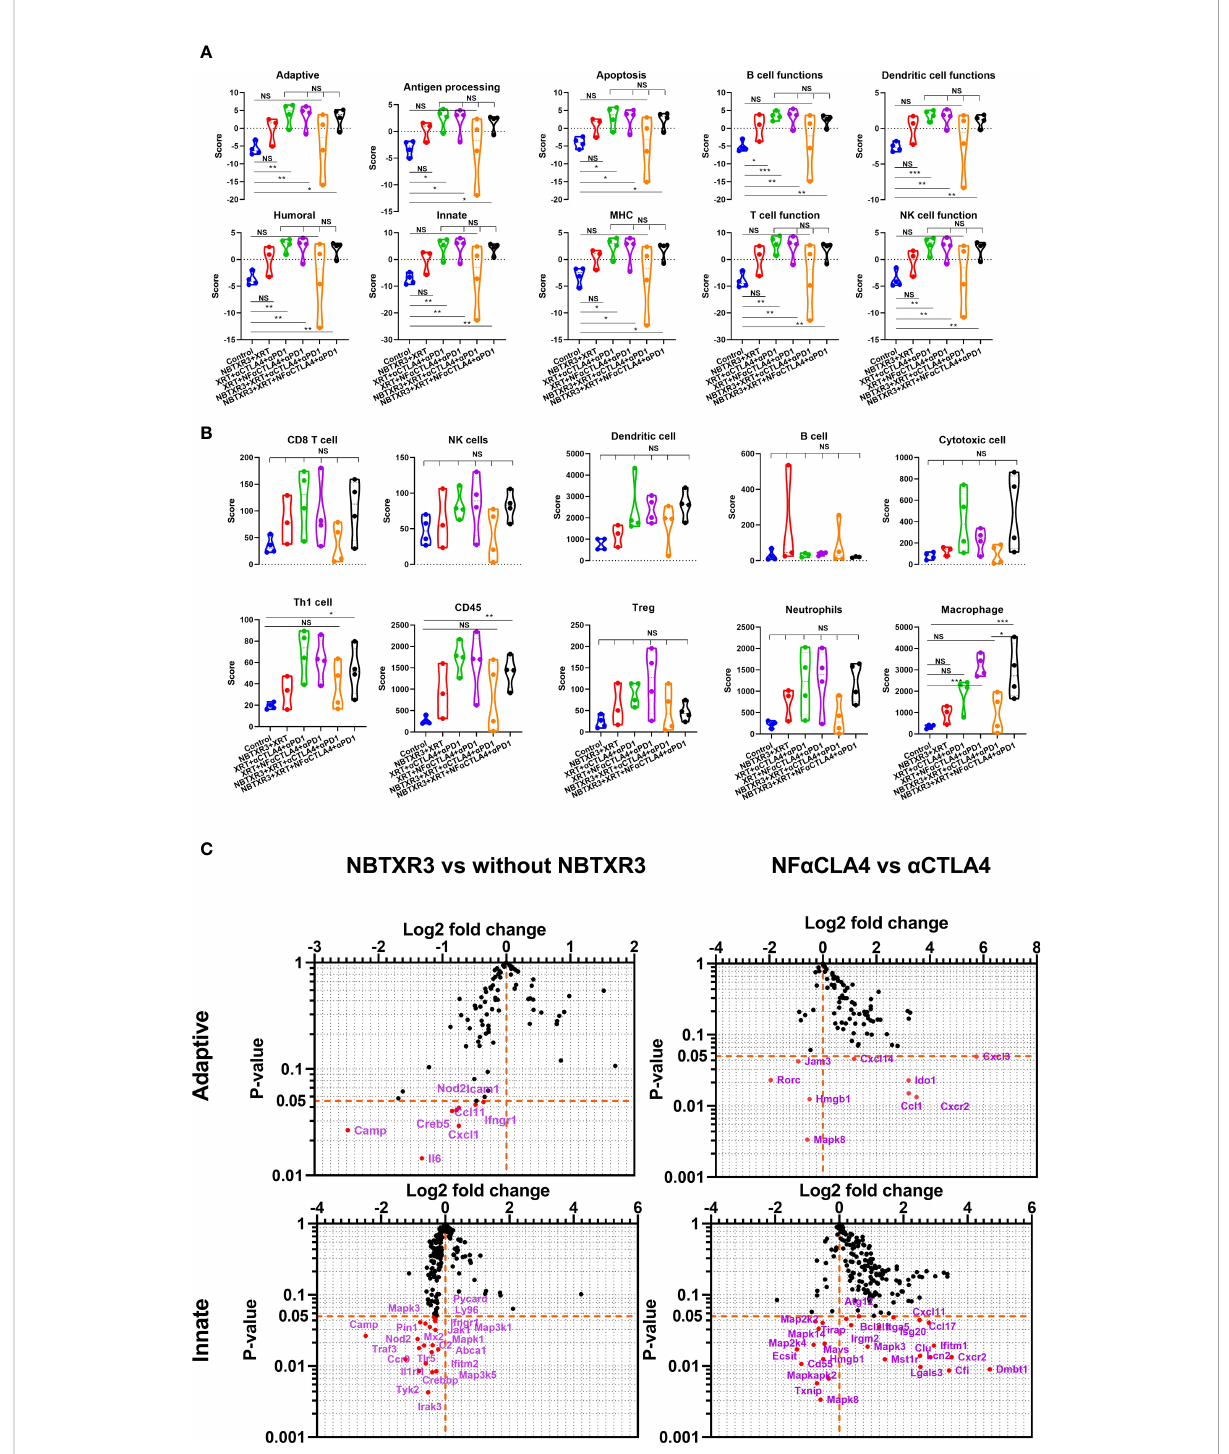
FIGURE 3 NBTXR3, combined with NF- a CTLA4, modulates immune-related gene expression to improve the primary tumor ’ s antitumor immune response. (A) Activities of immune pathways in the primary tumors. (B) The score of immune cell abundance in the primary tumor. (C) Changes in gene expression in adaptive and innate immune pathways. Mice bearing 344SQR tumors were treated with various immunoradiotherapies as indicated in Figure 1A, and the primary tumors were harvested on day 18. The RNA extracted from the tumors was analyzed by a nCounter PanCancer Immune Pro fi ling Panel. Data are expressed as means± SEM. P<0.05 was considered statistically signi fi cant. *P<0.05, **P<0.01, ***P<0.001, NS, not signi fi